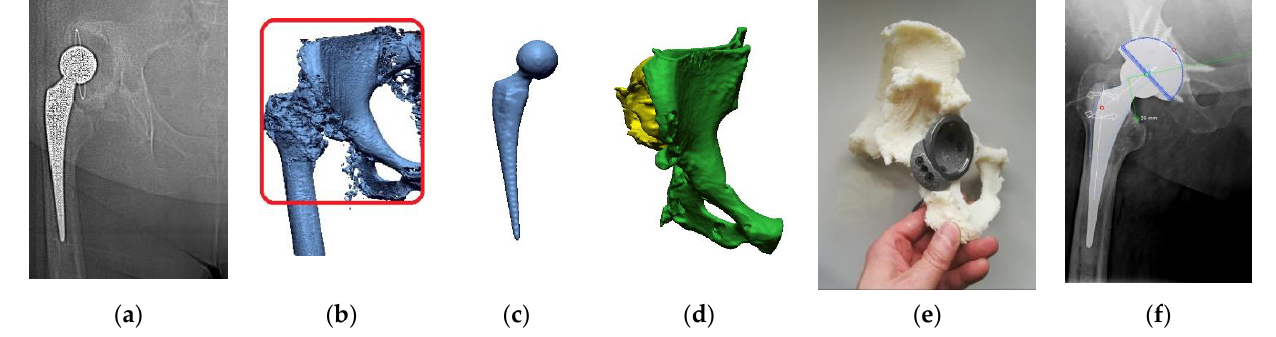
Figure 25. Process of planning the procedure as exemplified by Patient No. 7: ( a ) Diagnostics prior to the procedure; ( b ) Reconstruction of the volumetric data, together with the marked area to be printed; ( c ) The digital reconstruction of the endoprosthesis of the hip joint; ( d ) The digital reconstruction of the pelvis, together with the cement; ( e ) The printed model with adjusted implant; and ( f ) Diagnostics following the performed procedure.